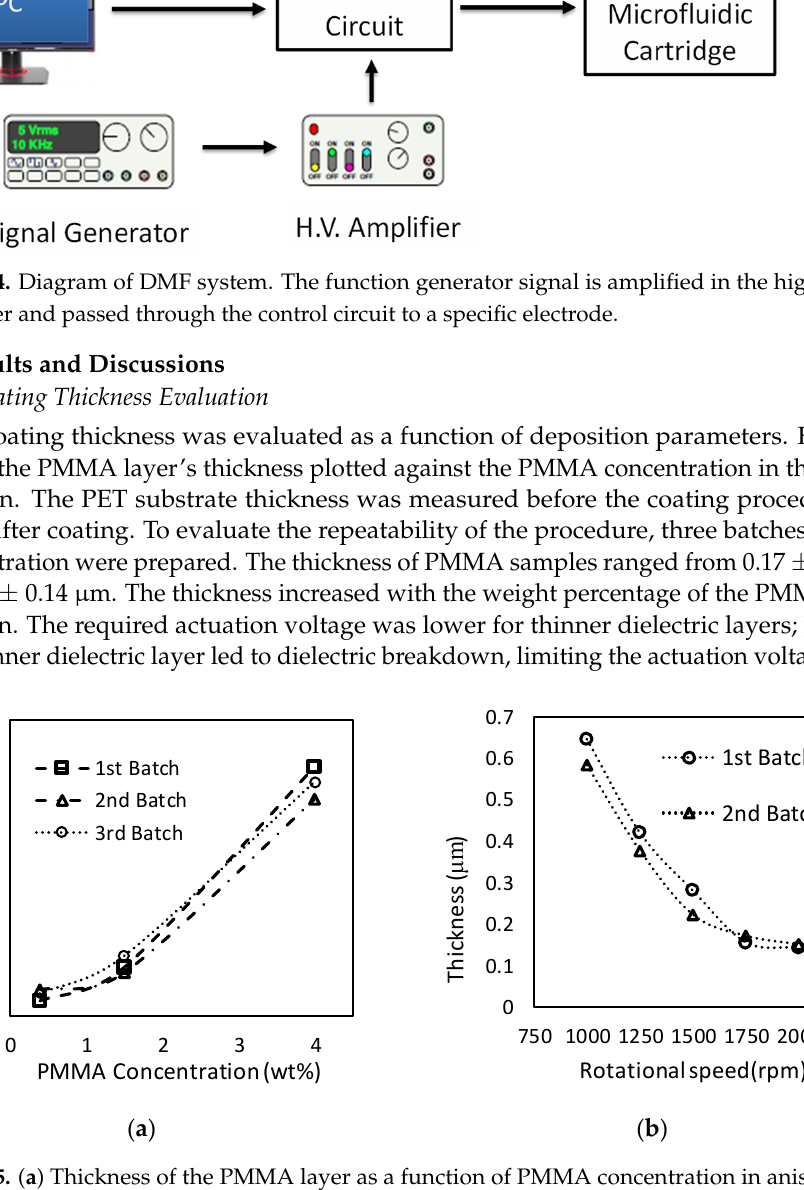
Figure 5. ( a ) Thickness of the PMMA layer as a function of PMMA concentration in anisole (0.4%, 1.5%, and 4%); the coater rotational speed was set to 1750 rpm. ( b ) Thickness of Fluoropel layer for spin coater settings of 1000 rpm, 1250, 1500 rpm, 1750 rpm, and 2000 rpm on Kapton.